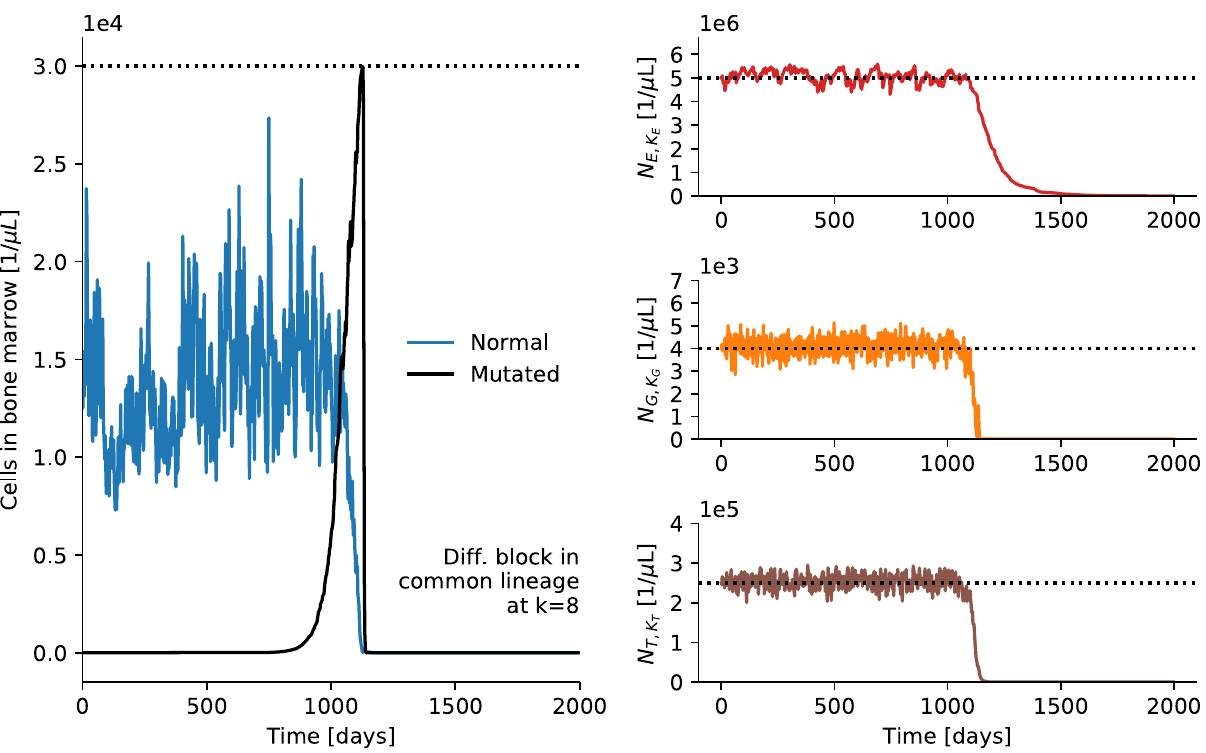
Fig 7. Early differentiation block. A differentiation block is introduced in the common precursor stage k = 8 at time zero. The blue plot in the left panel shows the number of normal cells in the bone marrow (per microliter blood in the body). After a nascent phase with slow growth the number of clones, shown in black, explodes. As in the right panel of Fig 6 the number of clones here is bound by a limited replicative capacity and comes down again. However, here we assume in addition that there is a limit to the number of cells that can be hosted by the bone marrow (dashed horizontal line) and excess cells are pushed into the blood stream. The panels on the right show the corresponding development of erythrocyte, granulocyte, and thrombocyte counts in the blood. After the bone marrow has been taken over completely by the mutated cells there is no more production of mature blood cells and hematopoiesis breaks down